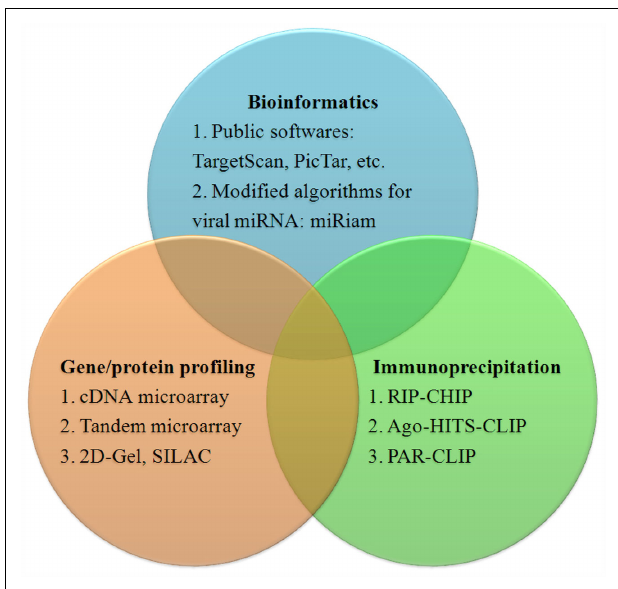
FIGURE 2 | Methods to identify miRNA